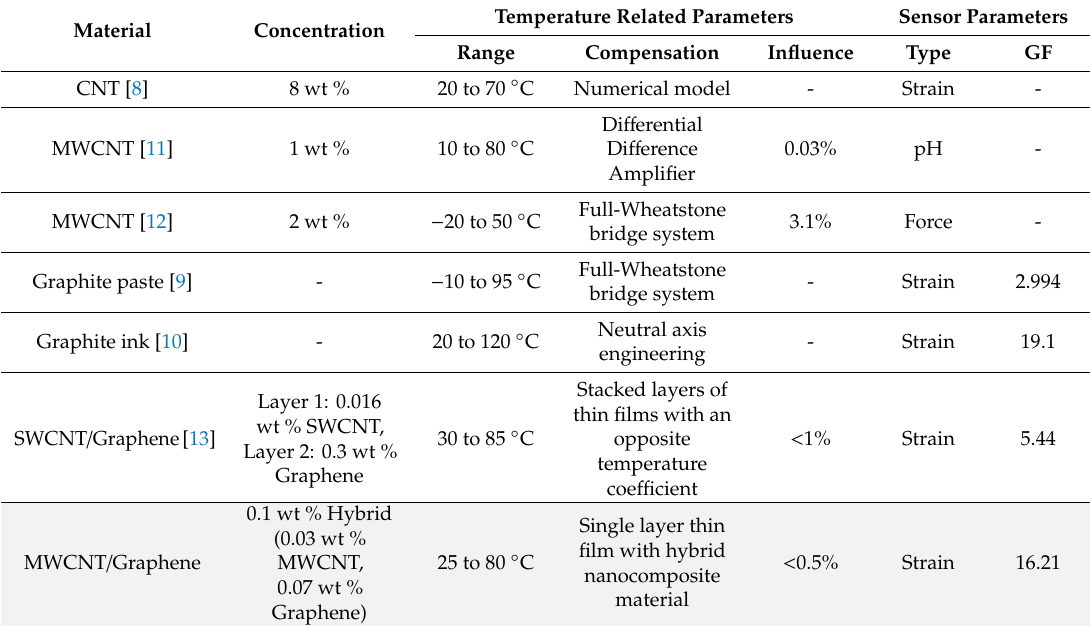
Table 1. Performance comparison of the synthesized hybrid sample (highlighted) with other, state of the art